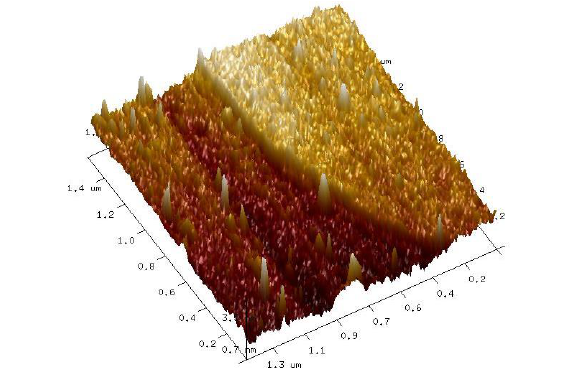
(d) The Section 3D figure of sensor surface ’ s active area for AFM characterization Figure 7. The AFM characterization figure of the sensor surface during the experiment process. ( a ) is the AFM characterization for sensor surface ’ s inactive area without graphene, ( b ) is the AFM ( a ) is the AFM characterization for sensor surface’s inactive area without graphene, ( b ) is the AFM characterization for sensor surface ’ s active area before graphene transfer, ( c ) is the AFM charac- characterization for sensor surface’s active area before graphene transfer, ( c ) is the AFM characteri- terization for sensor surface ’ s active area after graphene transfer, ( d ) is the Section 3D figure for AFM characterization with size and scale (size: 1.4 × 1.4 μm , scale: one line segment represents 0.2 zation for sensor surface’s active area after graphene transfer, ( d ) is the Section 3D figure for AFM μm ). characterization with size and scale (size: 1.4 × 1.4 µ m, scale: one line segment represents 0.2 µ